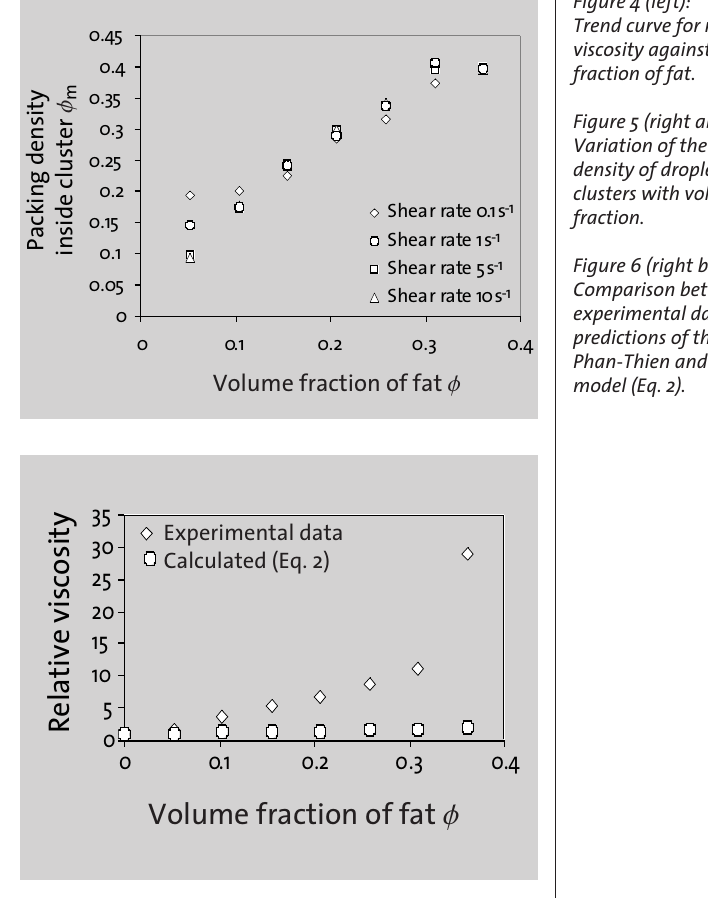
Figure 4 (left): Trend curve for relative viscosity against volume fraction of fat. Figure 5 (right above): Variation of the packing density of droplets inside clusters with volume fraction. Figure 6 (right below): Comparison between experimental data and predictions of the Phan-Thien and Pham model (Eq.